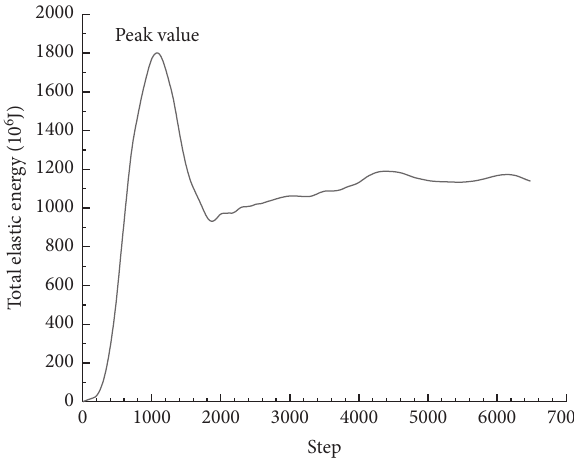
Figure 11: Variation of elastic energy in fault area.